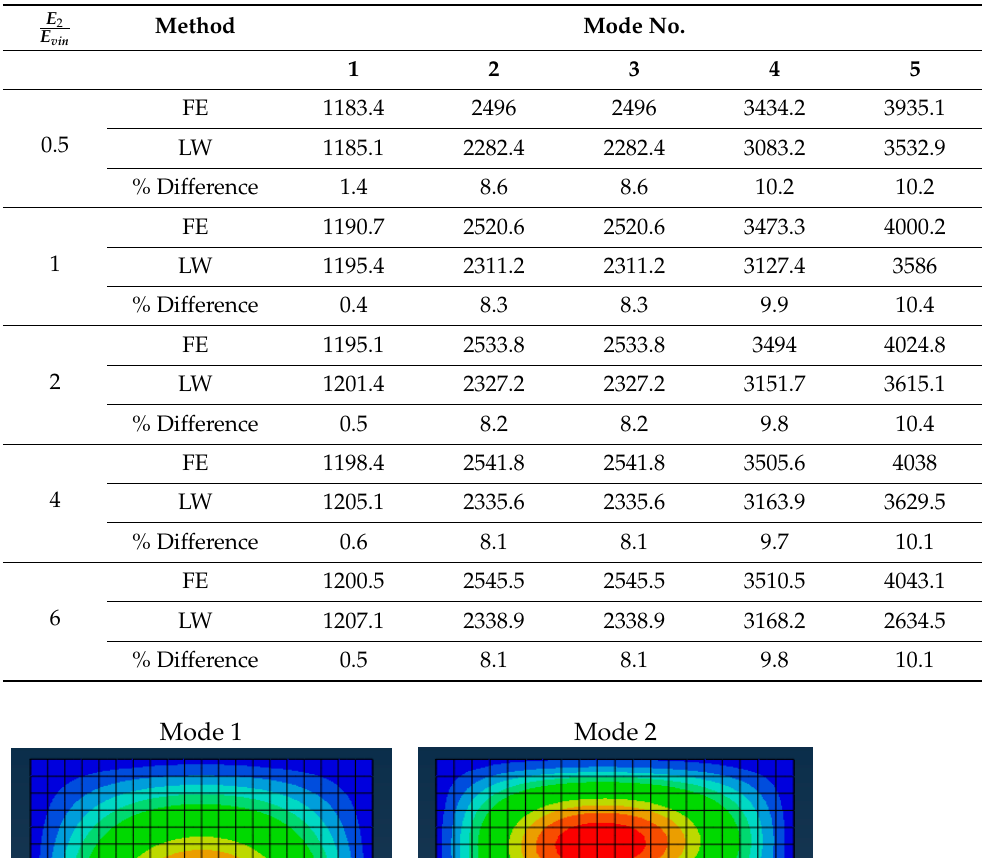
Table 15. The effect of any deviation in the adhesive elastic modulus from that of vinyl ester. Table 7. The mechanical properties of the five-layer sandwich plate.